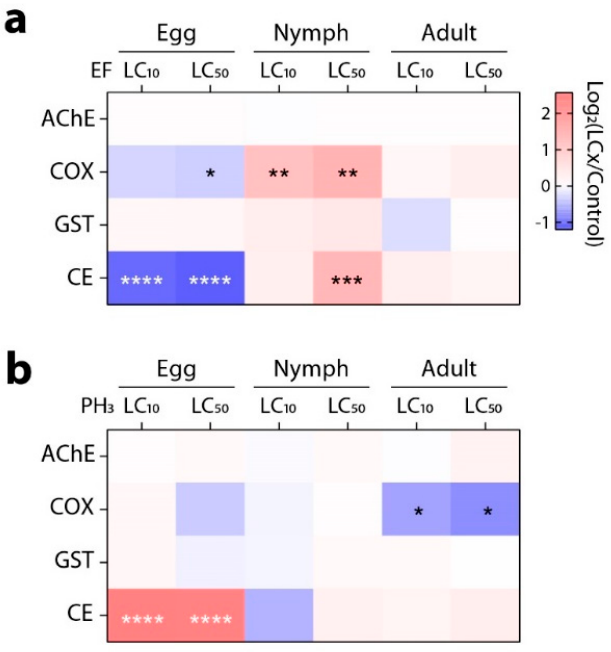
Figure 2. Heatmap of enzyme activities after exposure to ethyl formate (EF) for 4 h or phosphine (PH 3 ) for 20 h on P. citri (adults, nymphs, and eggs). Responses of four different enzymes, acetylcholinesterase (AChE), cytochrome c oxidase (COX), glutathione S-transferase (GST), and carboxylesterase (CE), after exposure to lethal concentration LC 10 and LC 50 values of EF ( a ) and PH 3 ( b ). A heatmap was constructed using the Log2 enzyme activity ratio between the control and treatment groups. Asterisks indicate significant differences (* p < 0.05, ** p < 0.01, *** p < 0.001, **** p < 0.0001) and no mark means ‘not significant’.